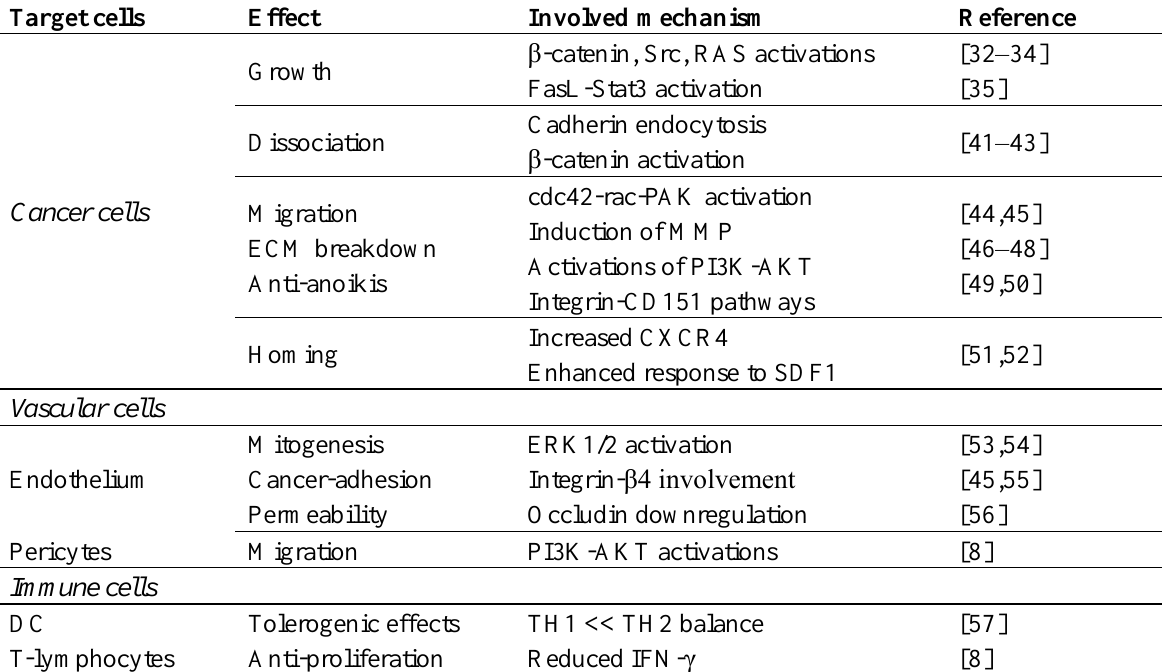
Table 1. Biological effects of HGF on intra-tumor